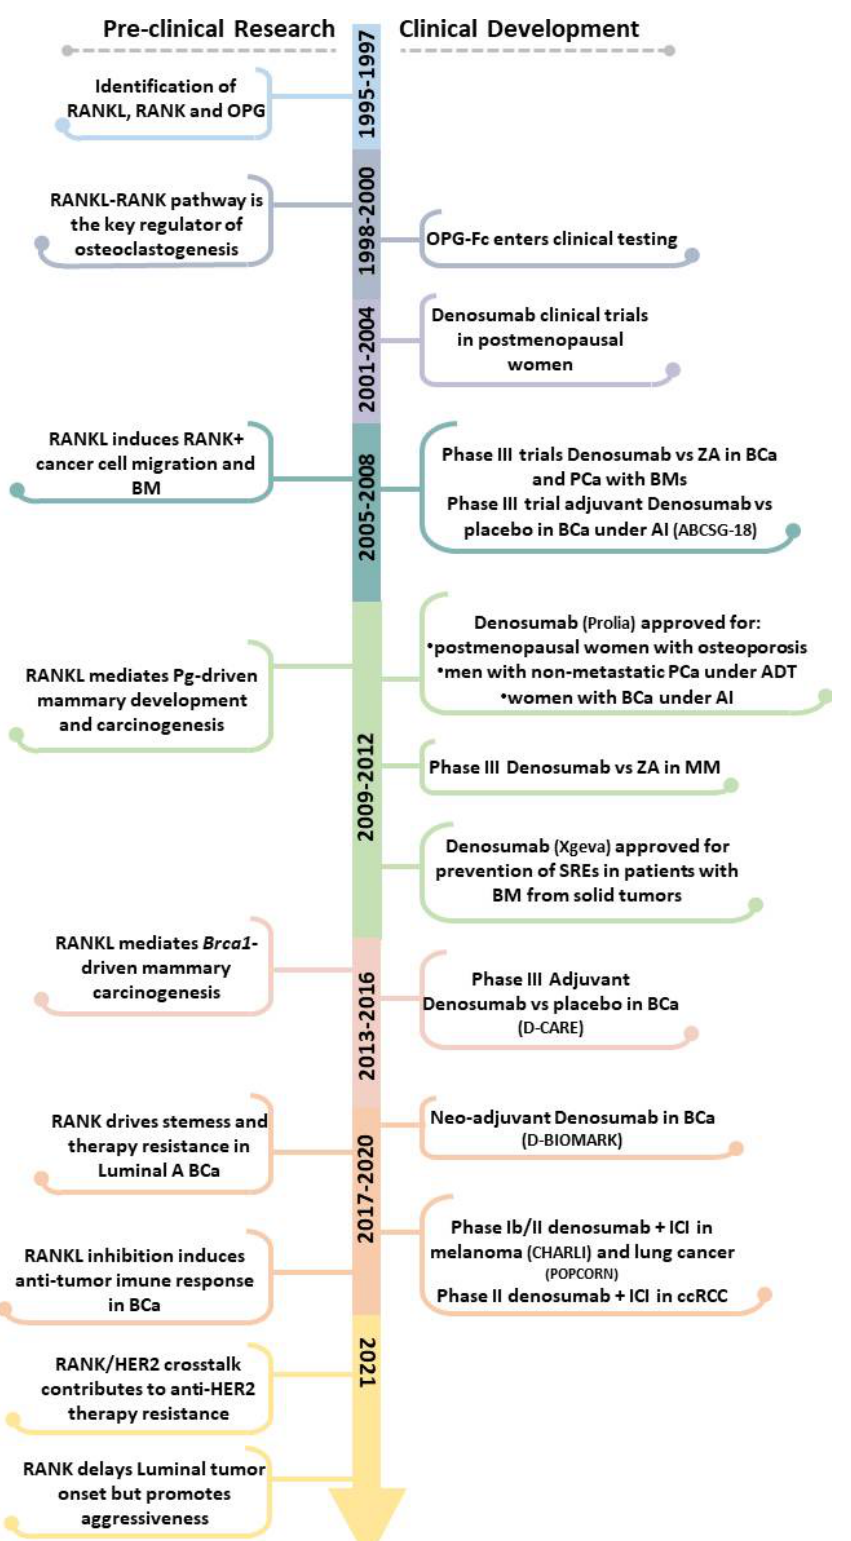
Figure 1. Pre-clinical and clinical landmarks of RANKL/RANK pathway research in Oncology. ADT, androgen deprivation therapy; AI, aromatase inhibitors; BCa, breast cancer; BM, bone metastases; ccRCC, clear cell renal cell carcinoma; ICI, immune checkpoint inhibitor; MM, multiple myeloma; PCa, prostate cancer; Pg, progesterone; SREs, skeletal-related effects; ZA,